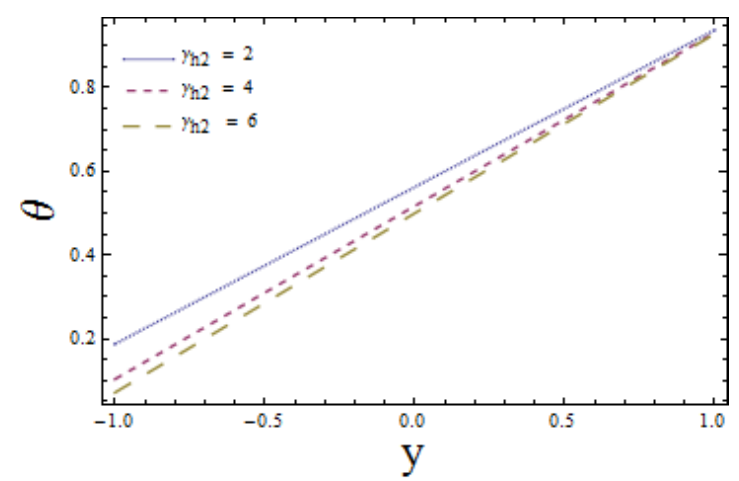
Figure 8. Temperature θ versus y for γ h 2 when (cid:101) = 0.2, x = 0.1, t = 0.1 and γ h 1 = 8.